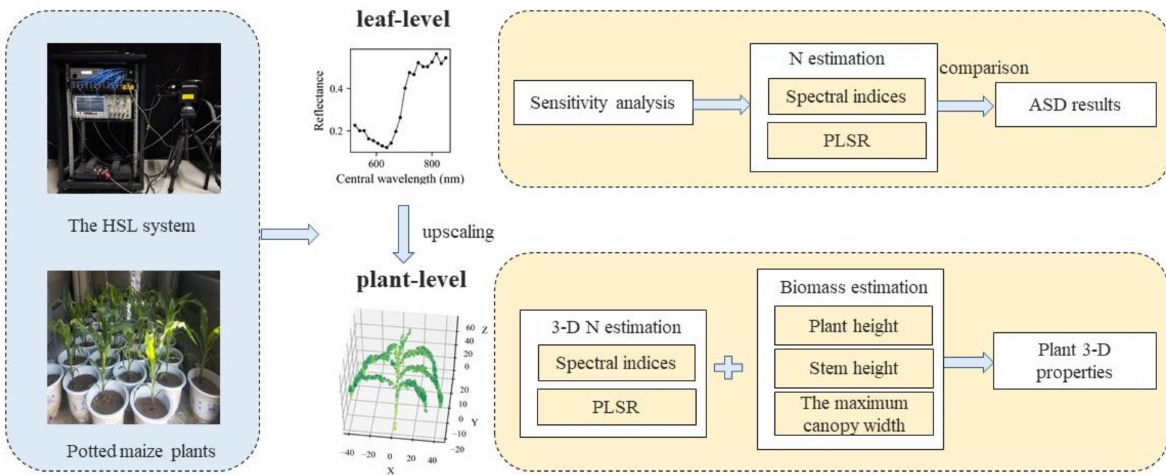
Figure 1. Workflow of the